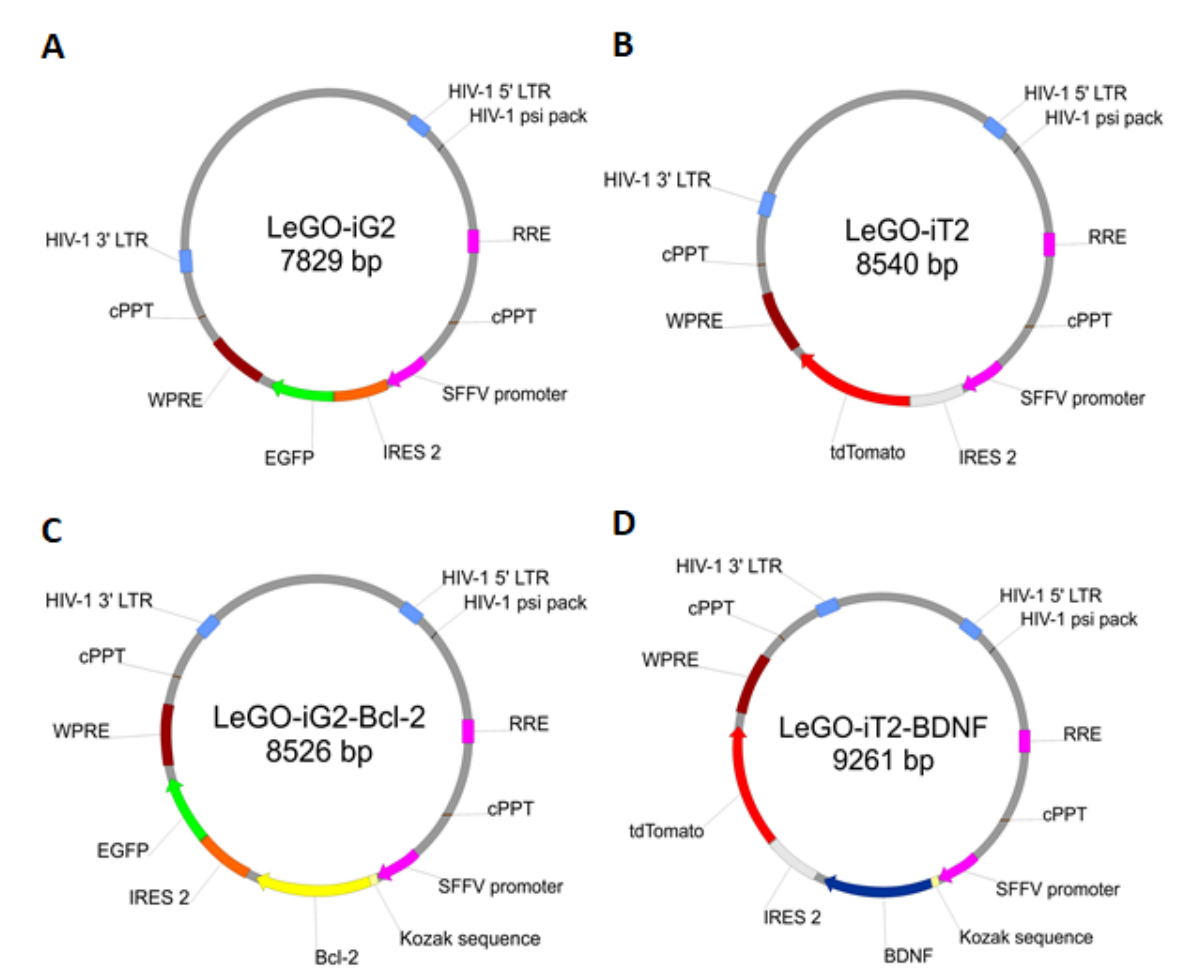
Figure 2. Lentiviral vector constructs. The lentiviral backbone plasmids contained the green fluorescence protein (EGFP) ( A ) or red fluorescence protein (tdTomato) ( B ). Into backbone A, coding sequence of BCL2 gene ( C ), and into backbone B, coding sequence of BDNF gene ( D ), were cloned to overproduced Bcl-2 and BDNF proteins. In the further parts of this work, plasmids A and B were used synergistically for transduction under the abbreviation EV—empty vectors, and plasmids C and D under the abbreviation FV—full vectors.